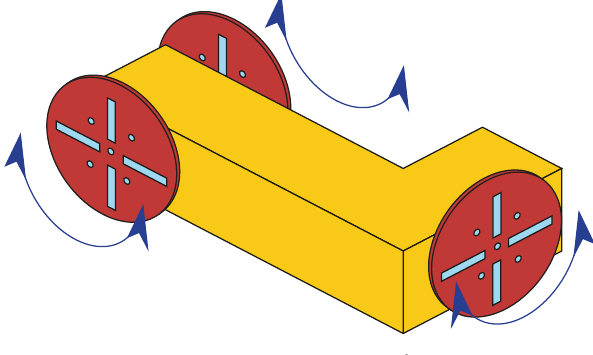
Figure 11: Model diagram of M 3 MSRR.